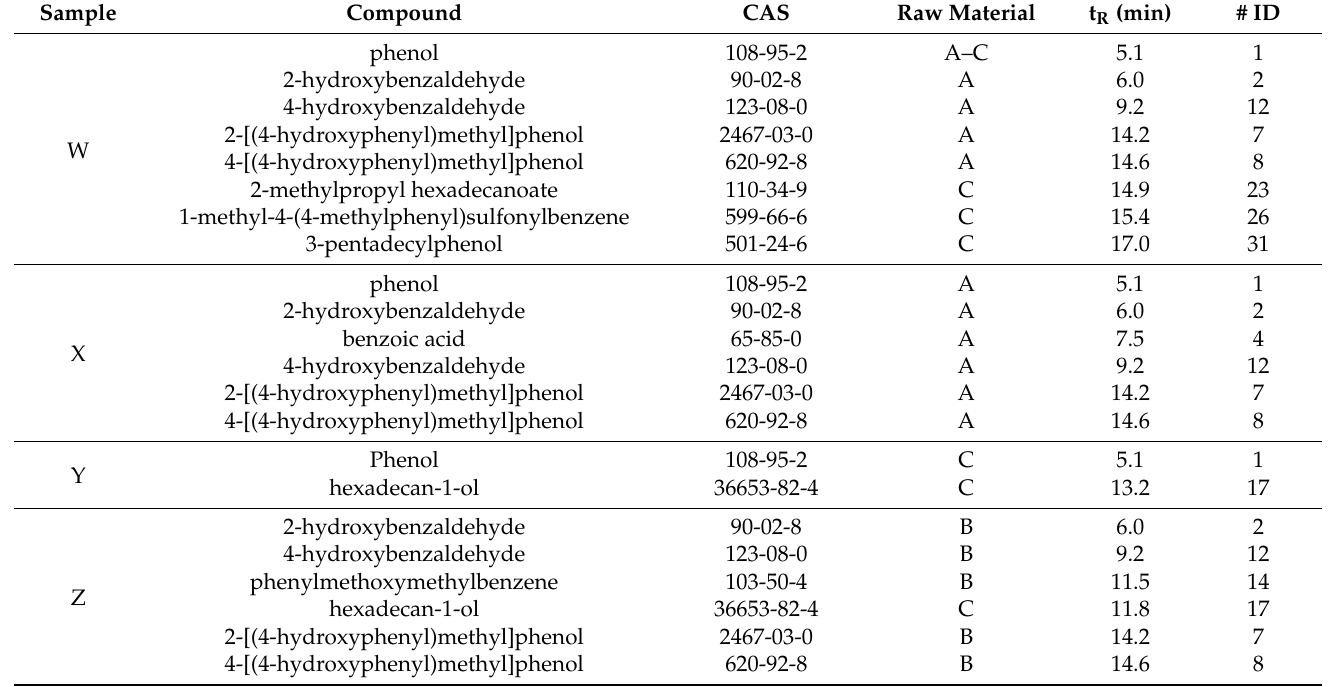
Table 4. Characteristic compounds in samples